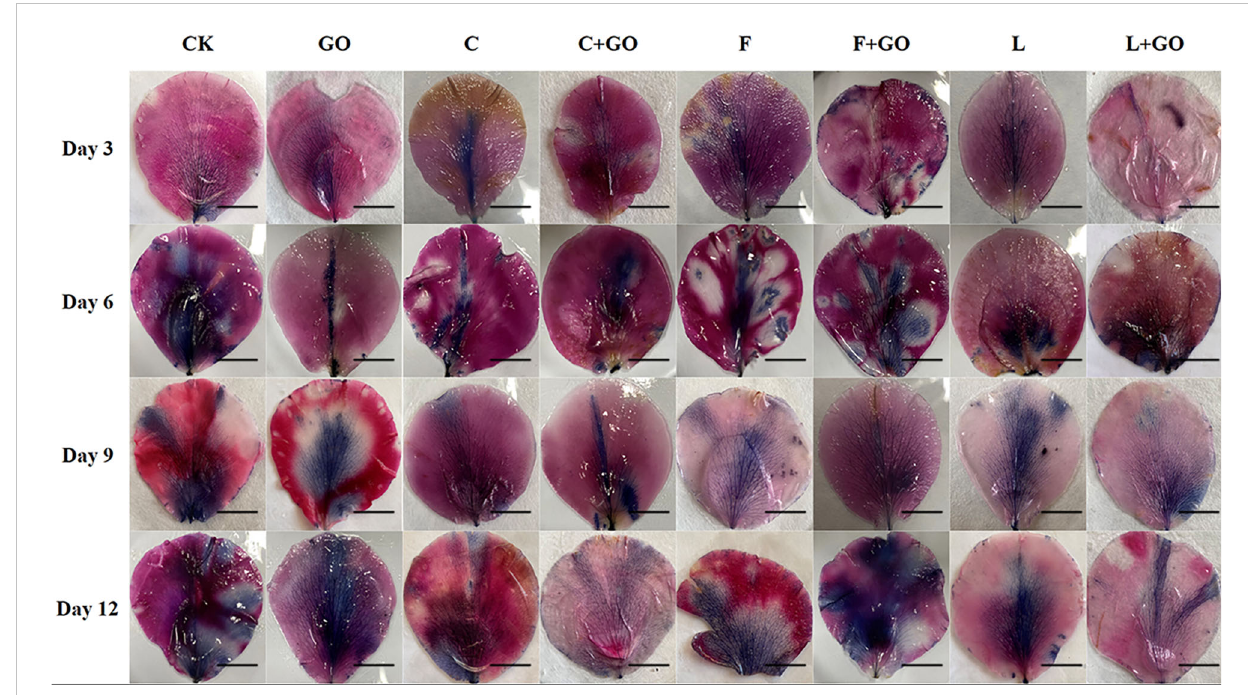
FIGURE 6 NBT staining results of the petals of the cut rose fl owers after 12 d of treatment. Scale bar: 1